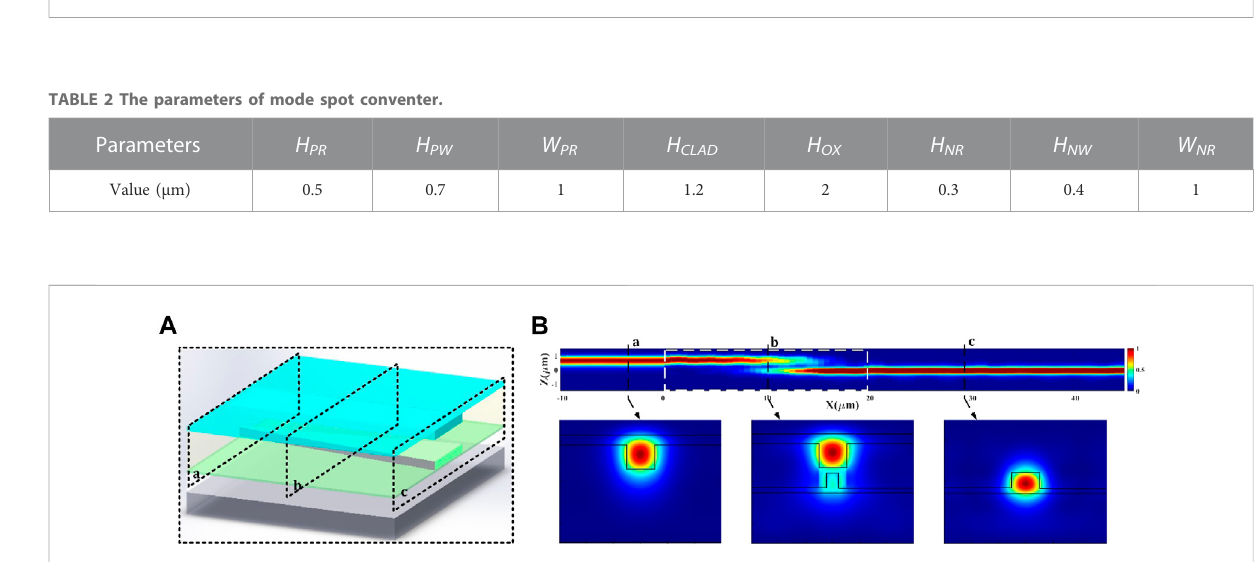
FIGURE 3 Longitudinal fi eld distribution of silicon nitride/organic polymer waveguide longitudinal adiabatic mode spot converter (A) the Schematic diagram (B) optical mode fi eld at different